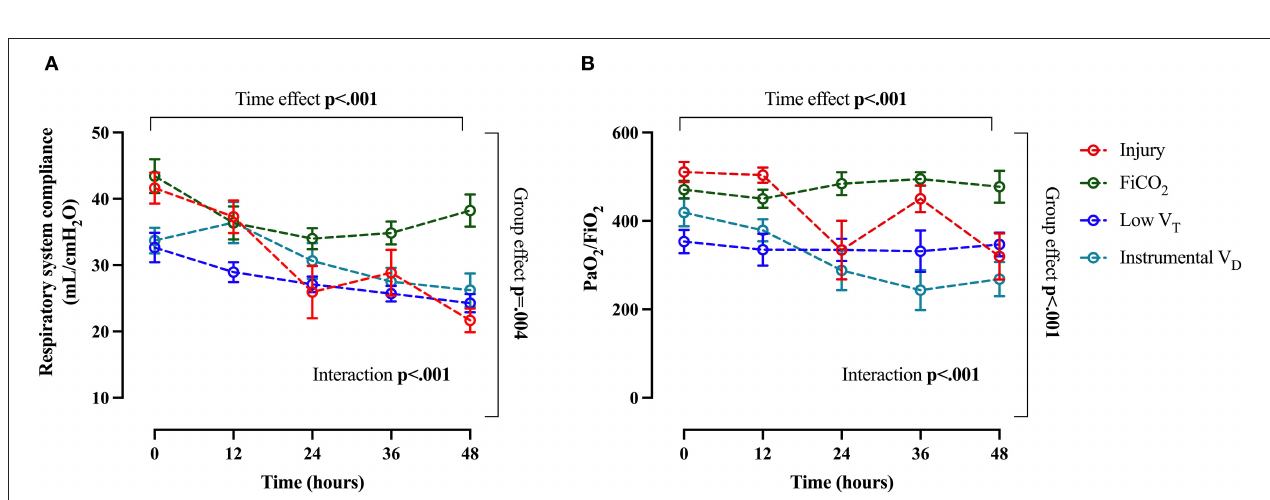
FIGURE 7 | Main global markers of injury. Trend of respiratory system compliance (A) and PaO 2 /FiO 2 (B) throughout the study. Data are expressed as mean ± SEM. Comparisons are obtained with two-way ANOVA test for normally distributed values followed by Dunnett’s multiple comparisons